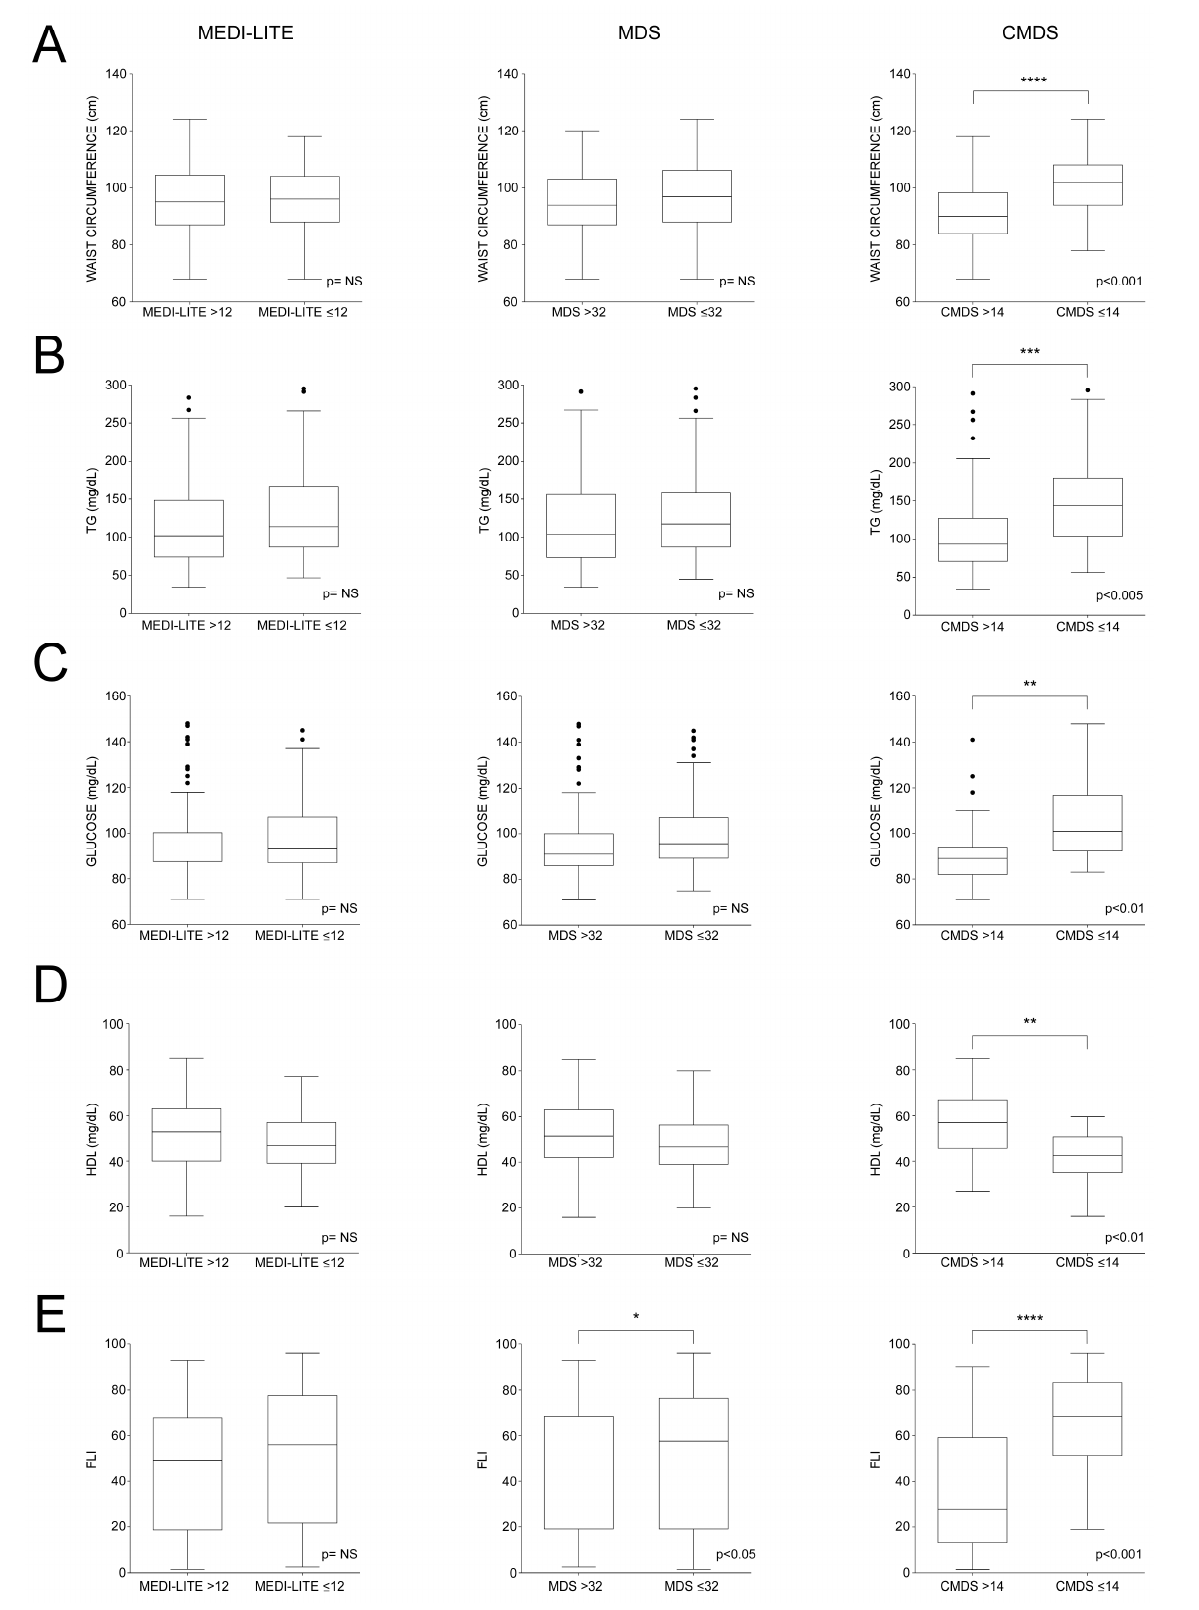
Figure 6. Dysmetabolic-related biomarkers in subgroups population identified according to MEDI- LITE, MDS, and CMDS cut-offs. Box plots show median (second quartile), first and third quartile. Tukey whiskers reach 1.5 times the interquartile distance or the highest or lowest point, whichever is shorter. Any data beyond whiskers are shown black dots. Comparisons were performed using Students(cid:31) t test. * p < 0.05, ** p < 0.01, *** p < 0.005; **** p < 0.001 indicates statistical signi fi cance. Abbreviations: triglycerides, TG; high-density lipoprotein cholesterol, HDL; Fa tt y Liver Index, FLI. ( A ) Box plots of waist circumference according to MEDI-LITE, MDS and CMDS cut-o ff s; ( B ) Box plots of triglycerides according to MEDI-LITE, MDS and CMDS cut-o ff s; ( C ) Box plots of glucose